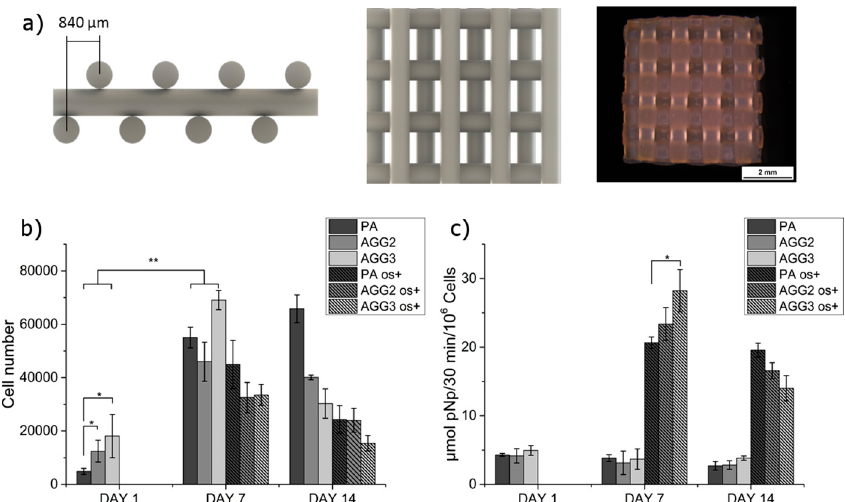
Figure 7. Cultivation of human mesenchymal stem cells (hMSC) on the scaffolds over a period of 14 days. ( a ) Illustration of the scaffold design with mismatch laydown pattern: CAD design (left and center) and microscopical image/top view (right); ( b ) cell number calculated from the DNA content and ( c ) specific alkaline phosphatase (ALP) activity of hMSC cultured on scaffolds when ostegenically induced (os+) and uninduced. (mean ± SD; n = 3; * p < 0.05, ** p < 0.005).